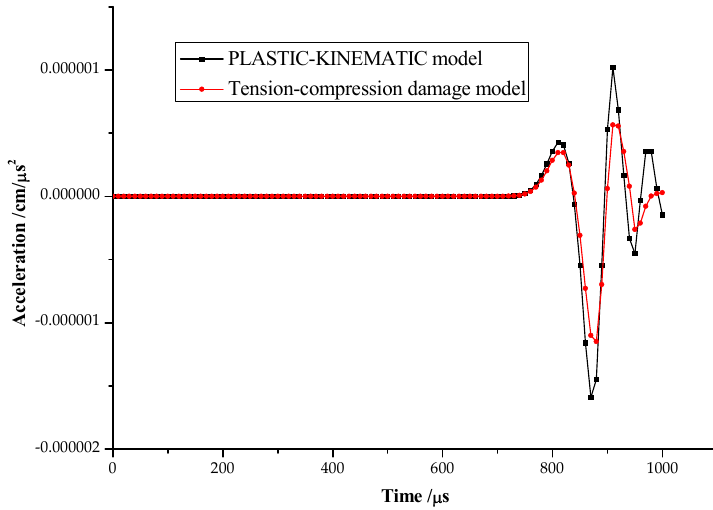
Figure 6. Acceleration–time curves for monitoring point 2.